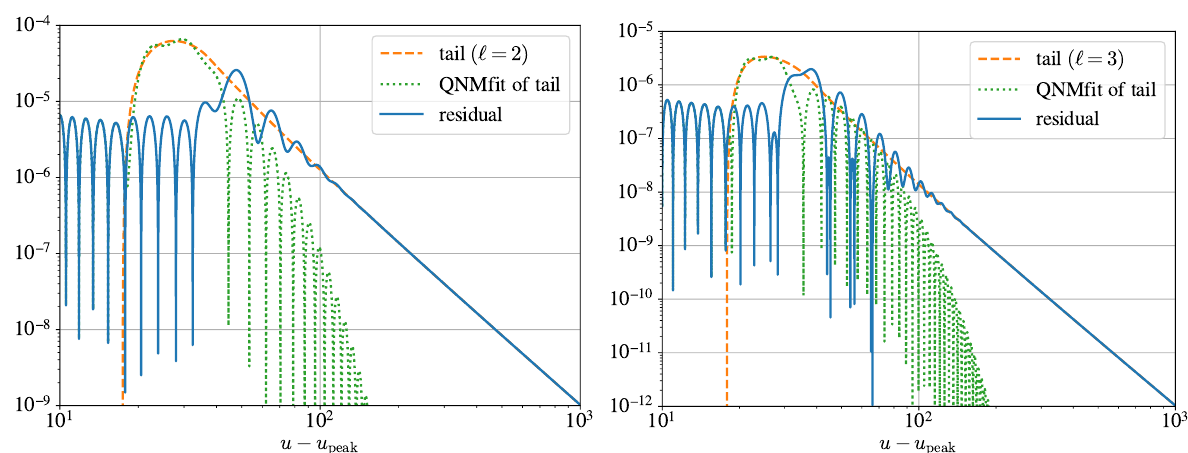
Figure 5. Analysis of mock data of the tail component in Equation (38) (the orange dashed lines). We plot the ( (cid:96) = 2 ) and ( (cid:96) = 3 ) modes in the ( left ) and ( right ) panels, respectively. The green dotted lines show the QNM fit including overtones with N = 7, and the blue solid lines are the fit residuals. Here, we choose D l = 1, u 1 = u peak + 10 M and u 2 = u peak + 30 M in Equation (38) with Equation